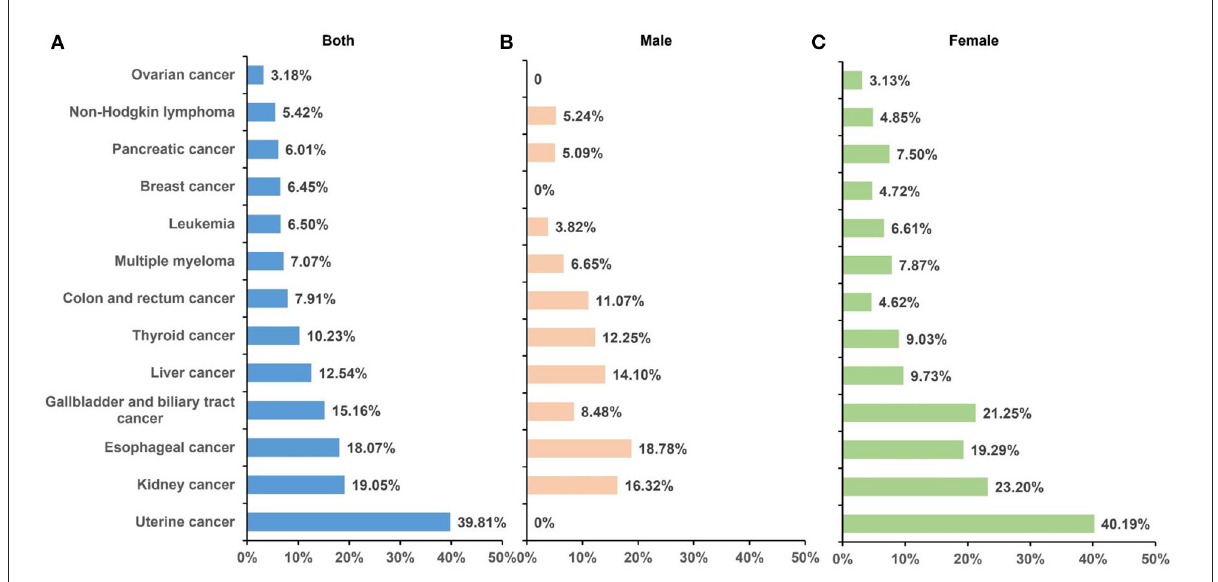
FIGURE3 Fraction of DALYs of cancer attributable to high BMI by sex in 2019. A total of 13 cancer types were found to be affected by high BMI, and the contribution of high BMI varies among sexes and cancer types. (A) Both sexes; (B) male; (C) and female. BMI, body mass index; DALYs, disability-adjusted